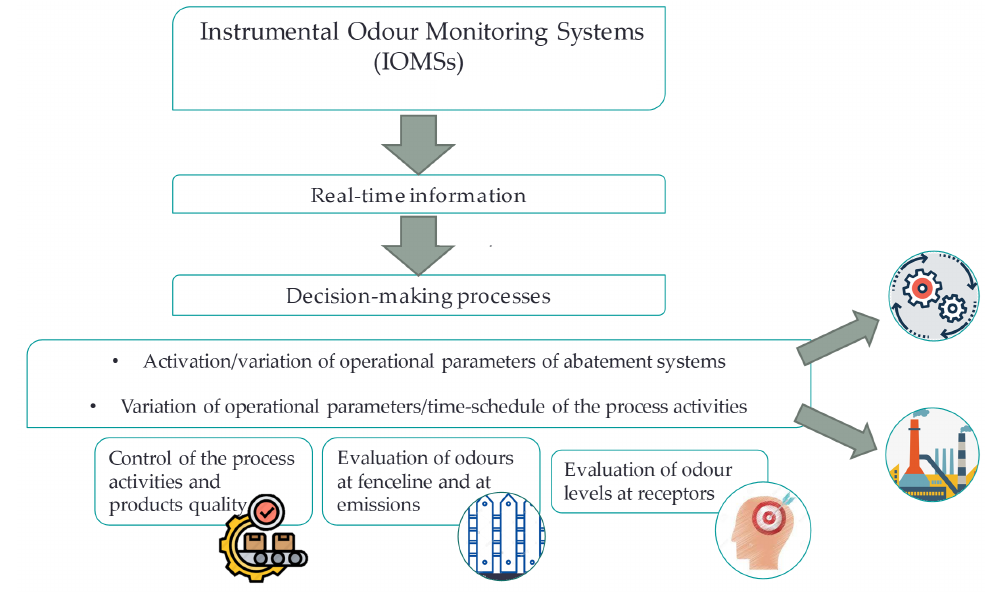
Figure 1. IOMS device—application fields.